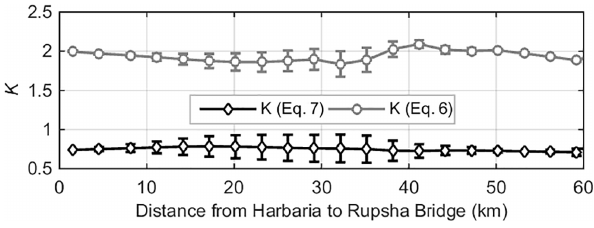
Figure 8. Spatial variation of Van der Burgh’s coefficient ( K) as calculated using Eqs. (6) and